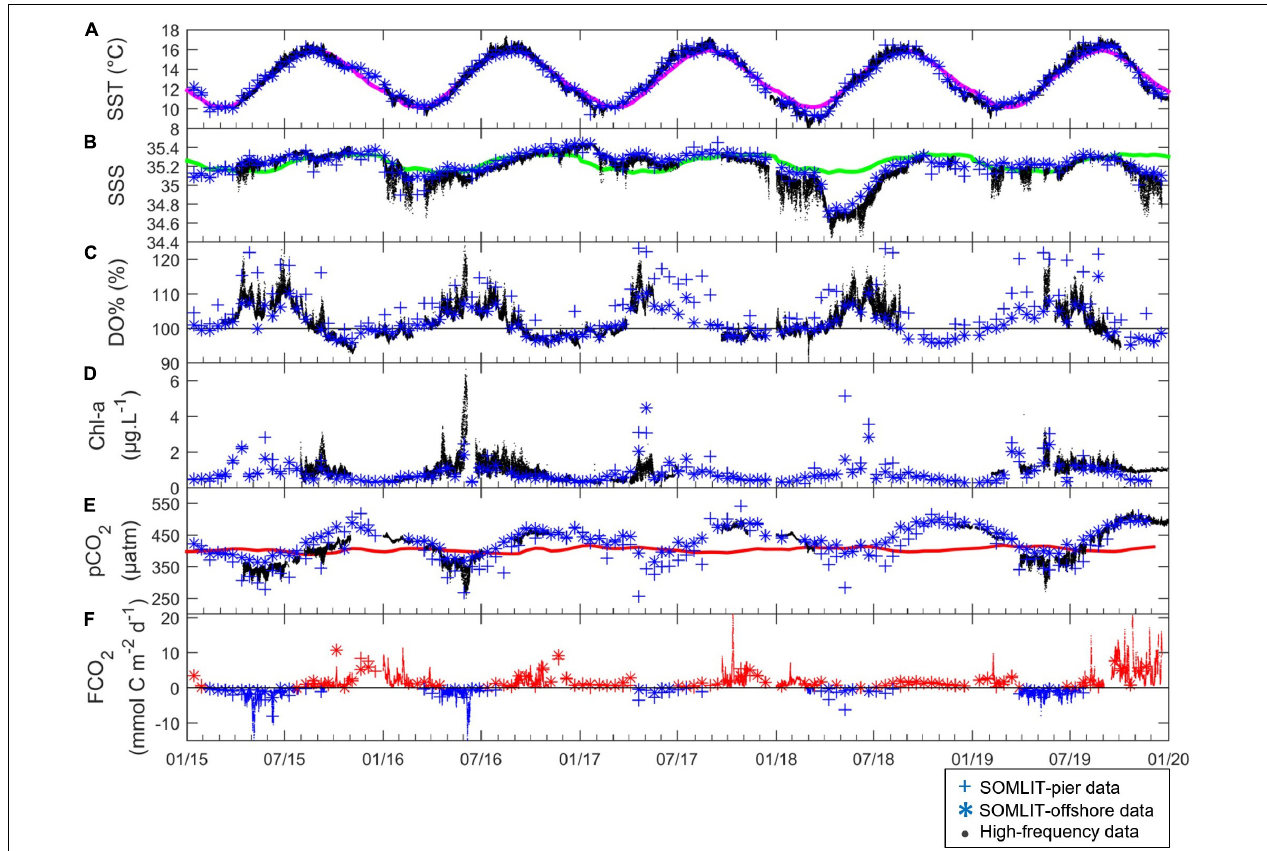
FIGURE 3 | (. in black) High-frequency, (+ in blue) SOMLIT-pier, and (* in blue) SOMLIT-offshore data of (A) SST ( ◦ C), (B) SSS, (C) DO% (%), (D) Chl-a ( µ g L − 1 ), (E) pCO 2 ( µ atm) and (F) FCO 2 (mmol C m − 2 d − 1 ) from January 2015 to January 2020. Colored lines represent the climatology of (A) SST, (B) SSS, and the pCO 2 atm ( µ atm) on (E) . The black lines of (C,F) represent the atmospheric equilibrium of DO and CO 2 , respectively. Negative FCO 2 (sink of atmospheric CO 2 ) values are represented in blue, and positive FCO 2 (source of CO 2 to the atmosphere) are in